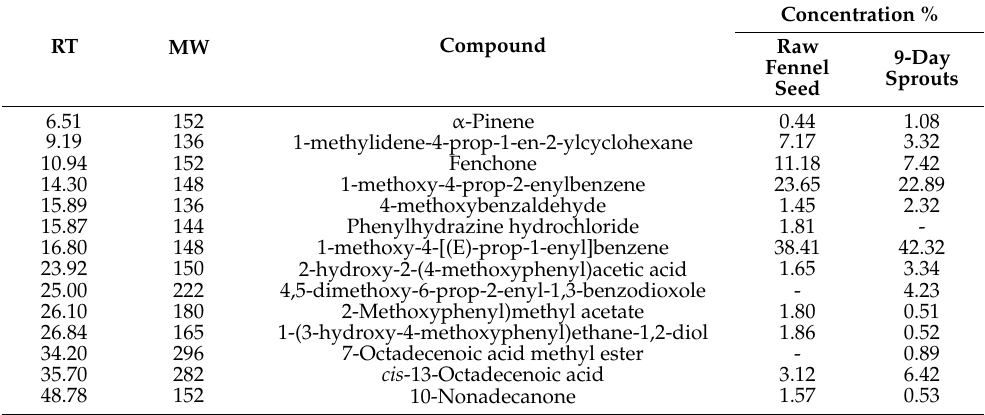
and 90–93% RH, n = 2.